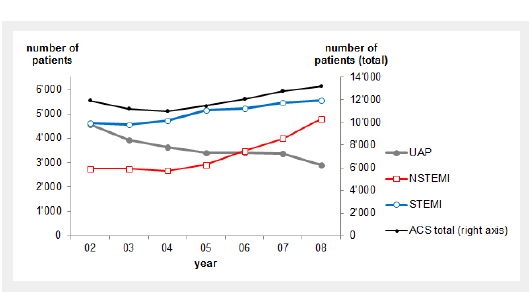
Age at ACS event leading to hospital stay in 2008. Own calculation on the basis of MedStat [11].